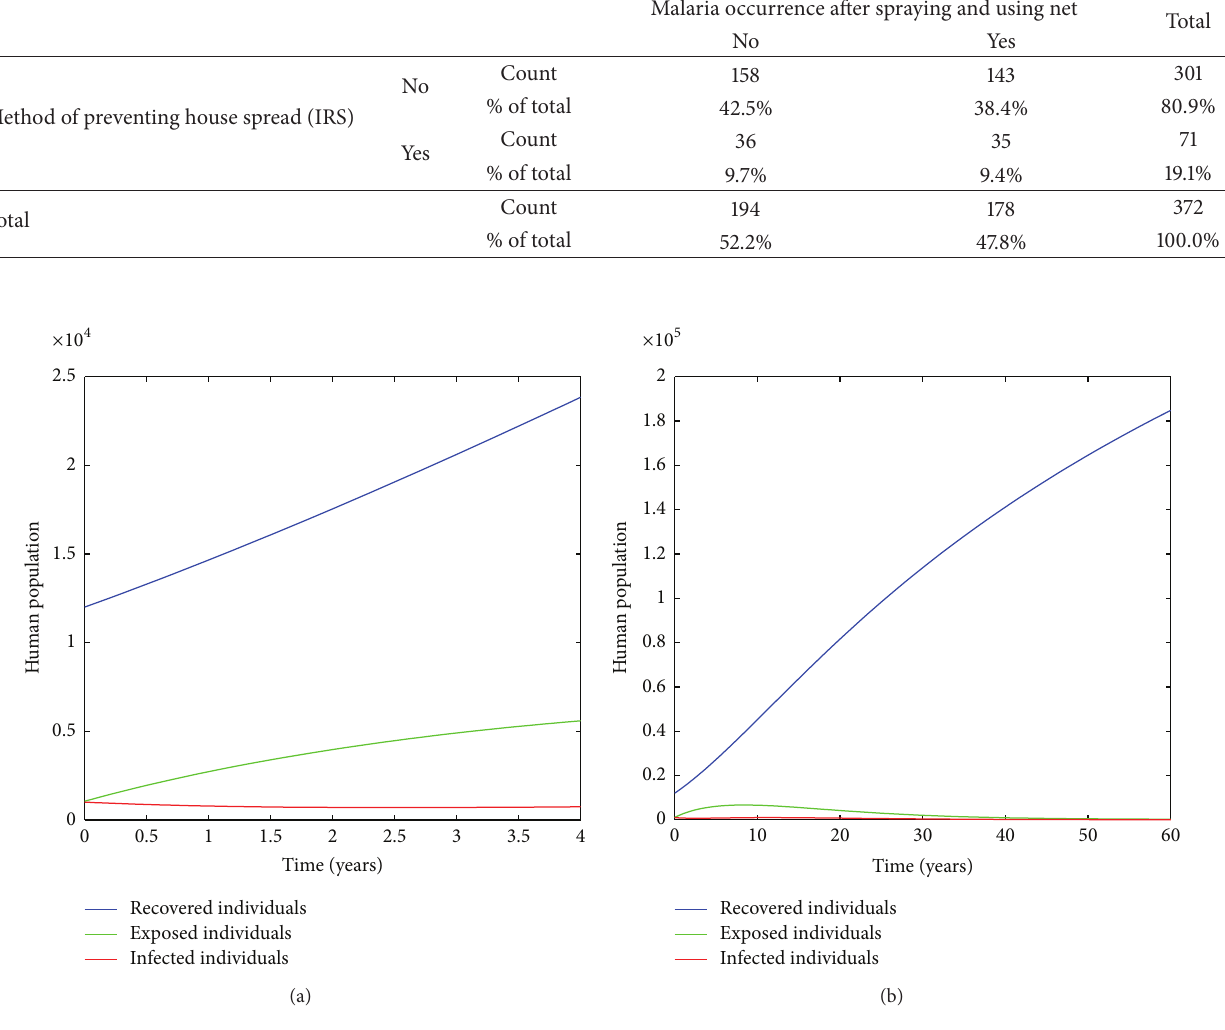
of a combination of the three intervention strategies and analyzing the potential impact of prevention with